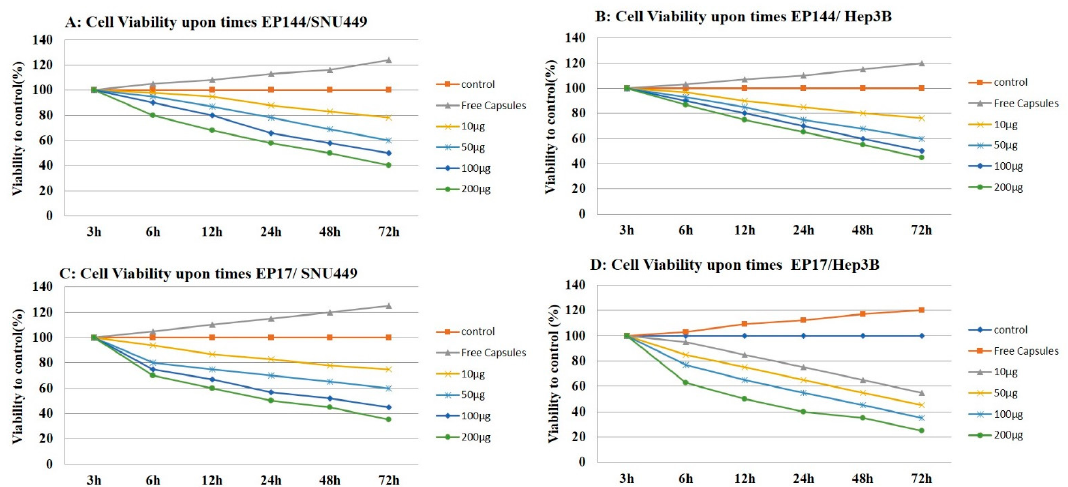
Figure 10. Cell proliferation assay. ( A ) Cell viability of SNU449 in a dose-dependent manner by using di ff erent concentrations of encapsulated P144. ( B ) Cell viability of Hep3B in a dose-dependent manner by using di ff erent concentrations of encapsulated P144. ( C ) Cell viability of SNU449 in a dose-dependent manner by using di ff erent concentrations of encapsulated P17. ( D ) Cell viability of Hep3B in a dose-dependent manner by using di ff erent concentrations of encapsulated P17.